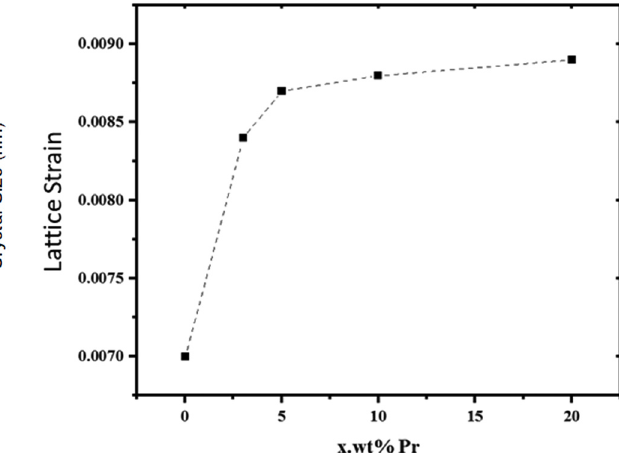
Figure 3: Crystal size of BiFeO 3 and Bi 1 − x Pr x FeO 3 fi lms using William – Hall and Debye Scherrer methods.